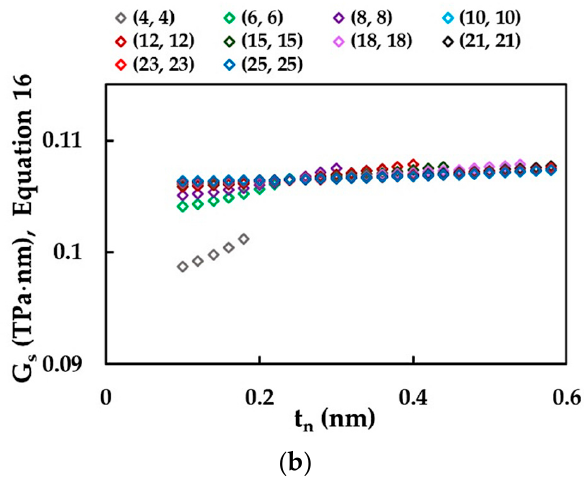
Figure 12. Evolutions of the surface shear modulus, G S , calculated with help of Equation (16), as a function of the wall thickness, t n , for ( a ) zigzag and ( b ) armchair SWSiCNTs.